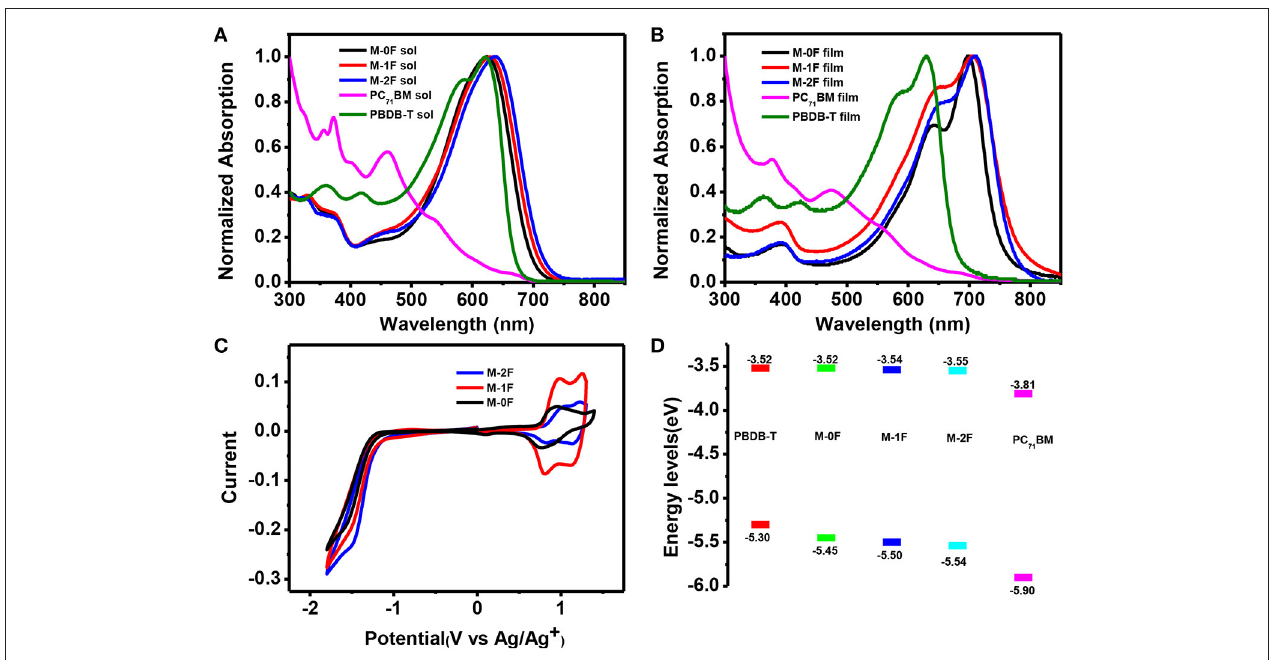
FIGURE 1 | (A) The normalized UV-vis absorption spectra of M-0F, M-1F, and M-2F, PC 71 BM, PBDB-T in chloroform and (B) in thin film (C) Cyclic voltammograms of M-0F, M-1F, and M-2F (D) Energy level diagram of the related materials used in the device.